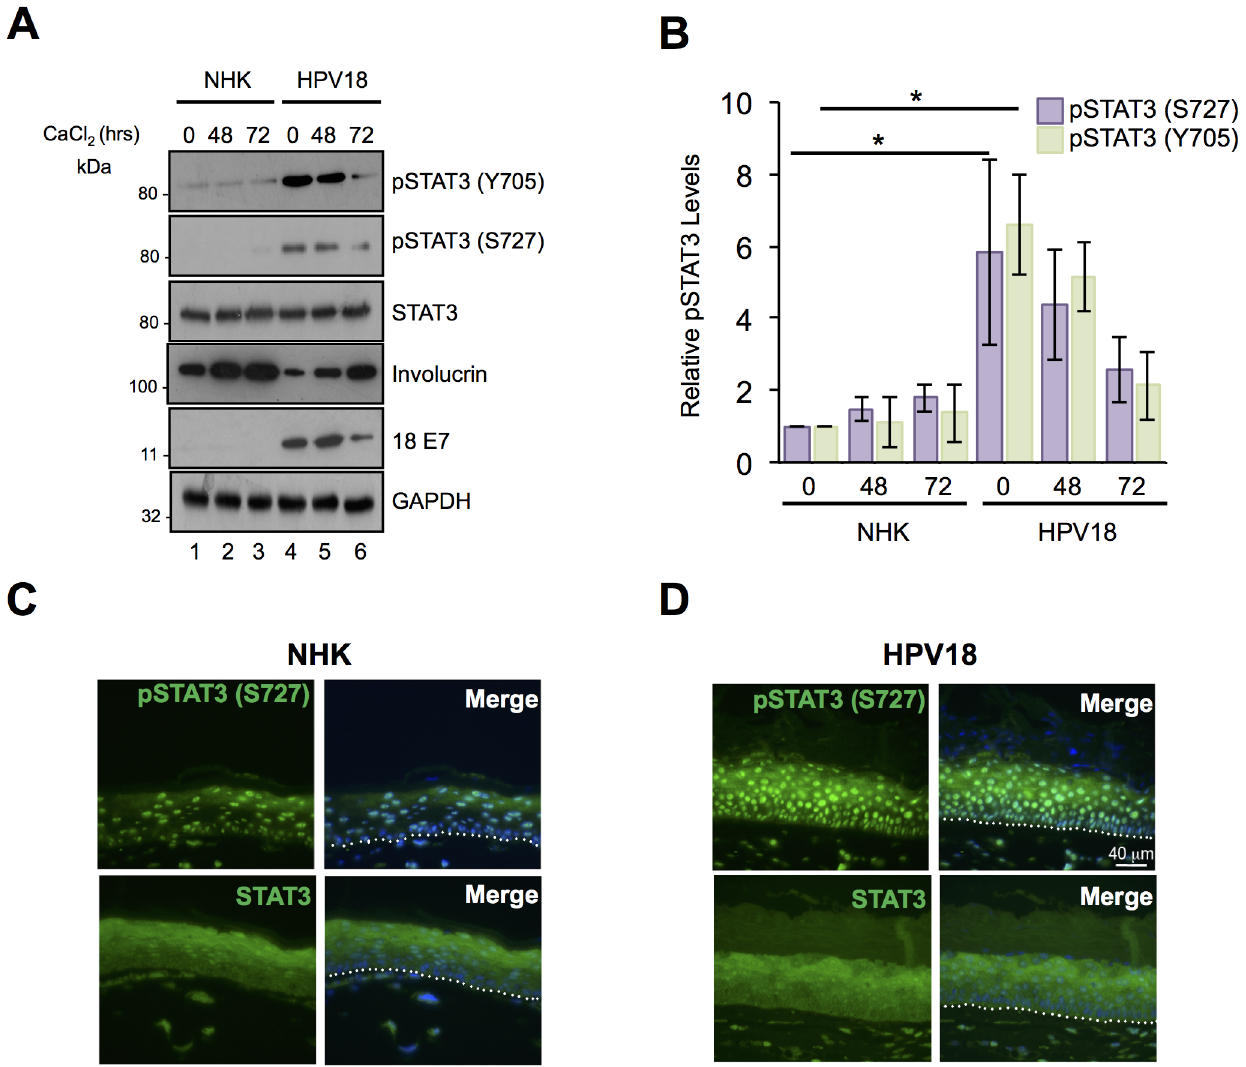
Fig 1. HPV18 induces the activation of STAT3 in primary human keratinocytes. A) Representative western blots of normal human keratinocytes (NHK) and HPV18-containing keratinocytes subjected to high calcium differentiation and analysed for STAT3 phosphorylation using specific antibodies